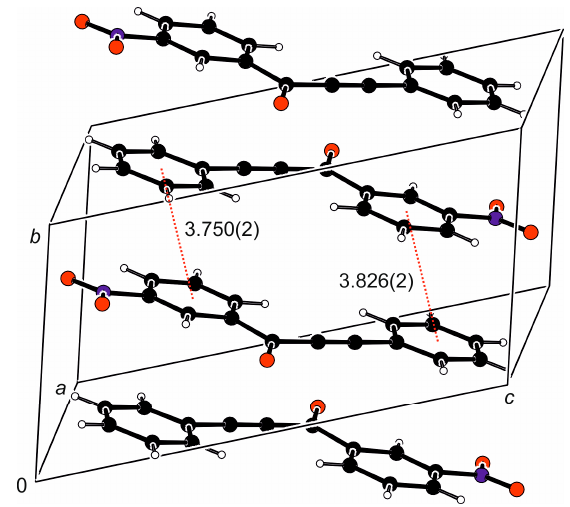
Figure 8. Section of the columnar stacks in the structure of 11af . The π ··· π interactions of the parallel benzene rings are indicated by red dotted lines, and the centroid···centroid separation is given in Å.